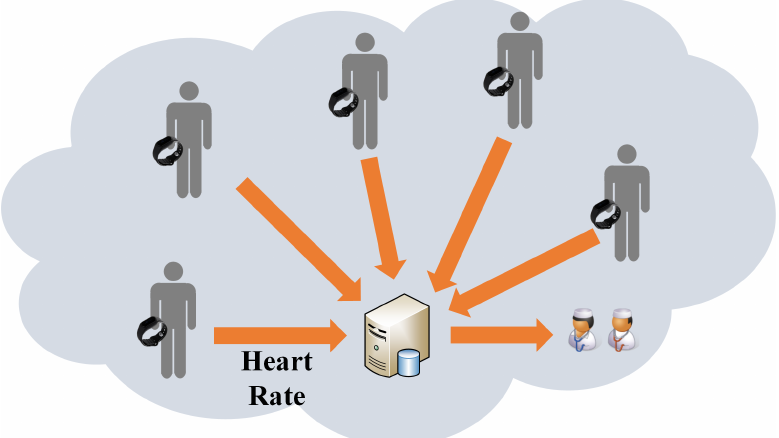
Figure 1. Application scenario. Heart rate (HR) information is collected by wristbands from patients inside the ward and forwarded to an openEHR service (center), where it is available to medical personnel (right) and can trigger